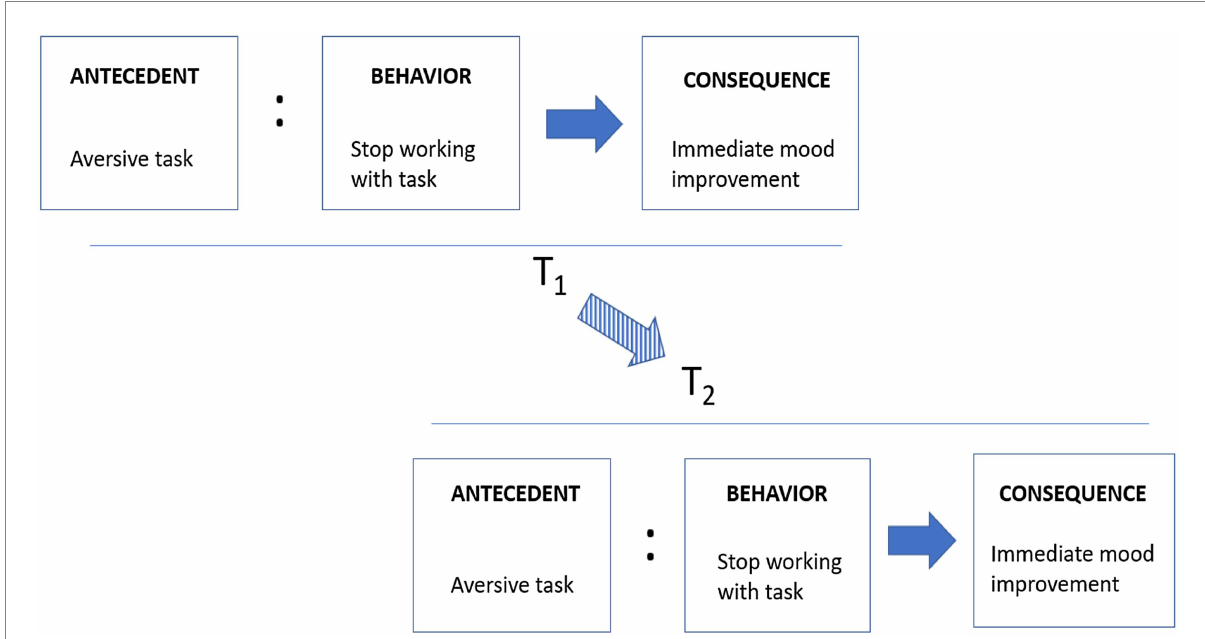
FIGURE 1 Schematic model of functional analysis, using negative reinforcement (escape) as an example. The antecedent (aversive task) sets the occasion for a procrastinatory behavior (stop task work), resulting in immediate mood improvement (consequence). Note that the Antecedent - Behavior relation is probabilistic (indicated by “:”), whereas the Behavior ➔ Consequence relation is causal. Note also that the negative reinforcement episode at T 1 increases or maintains the probability that similar behaviors will be repeated under similar antecedents later (T 2 , and so on). Therefore, functional analysis is longitudinal and processual in nature, capable of capturing the dynamic effect of repeated reinforcement